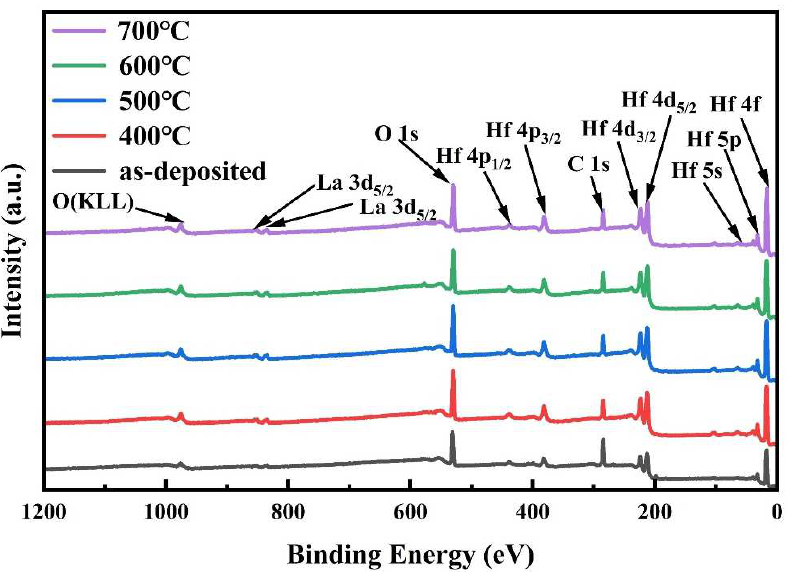
Figure 5. Broad-spectrum XPS spectra of lanthanum-doped HfO 2 films at different temperatures.